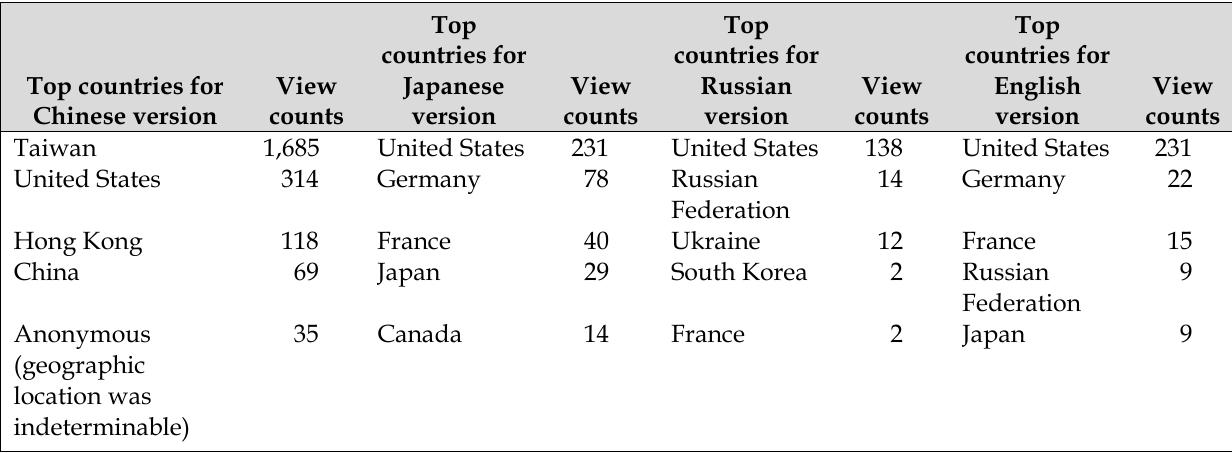
Table 2 Top five countries for the traffic sources of different language versions (June 11, 2014 to April 7, 2016)